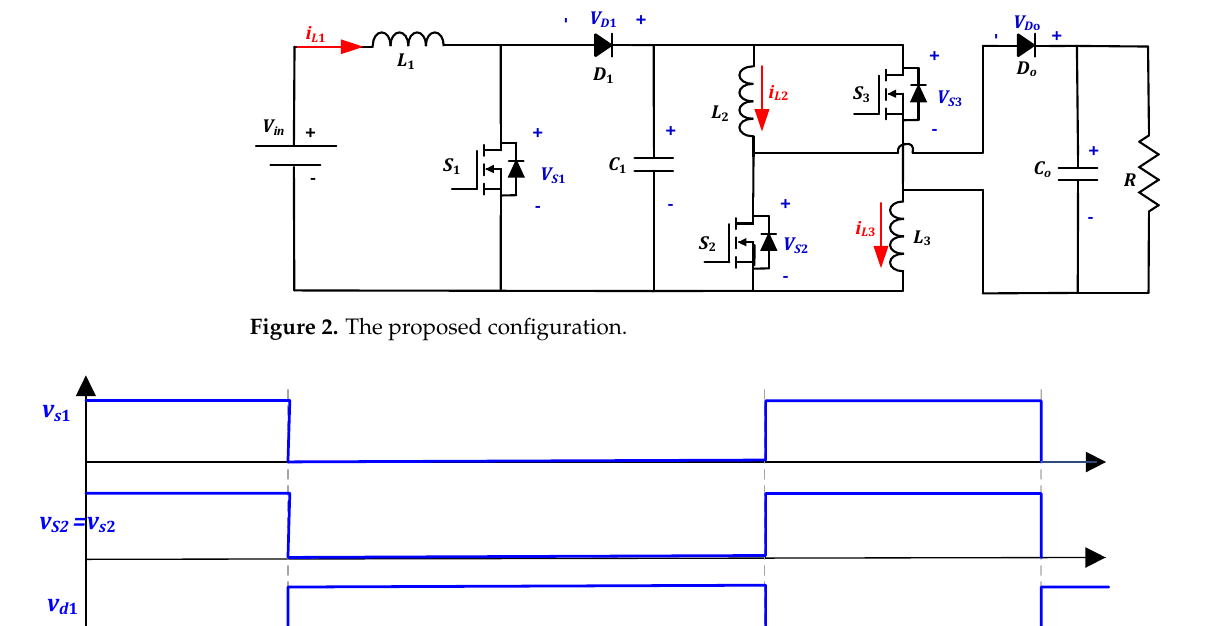
Figure 3. The ideal key waveforms of the converter.